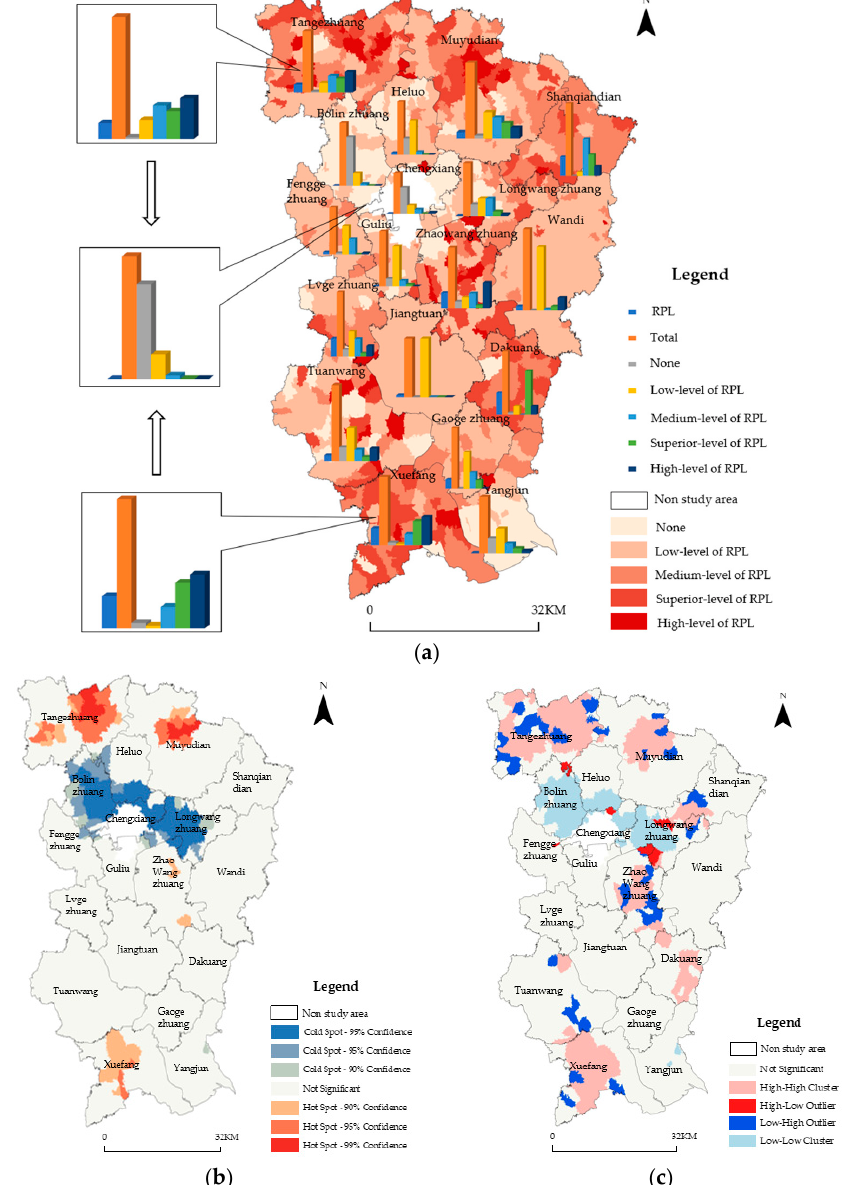
Figure 4. Spatial patterns of RPL in Laiyang County. ( a ) Spatial distribution. ( b ) Hotspot analysis and distribution. ( c ) Spatial autocorrelation distribution.